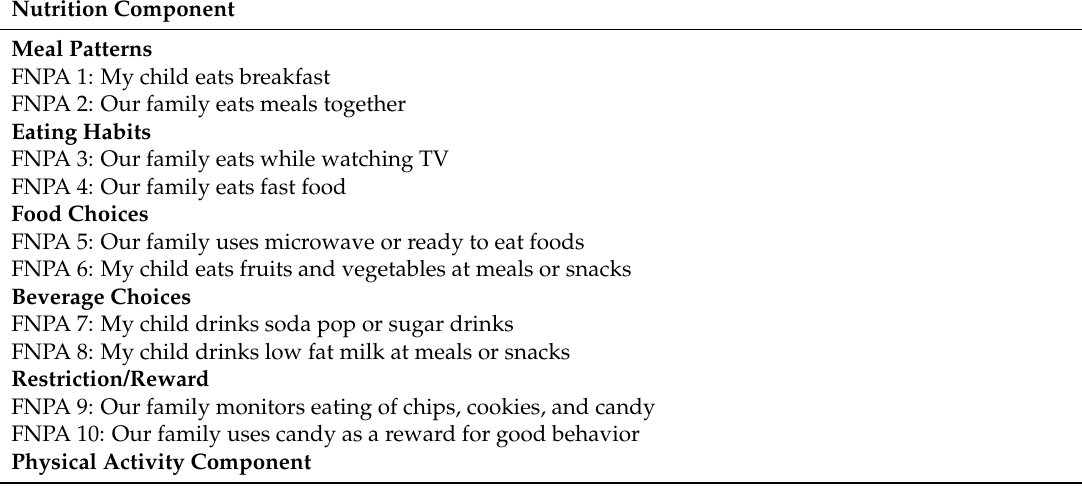
Table 1. Family Nutrition and Physical Activity (FNPA) factors